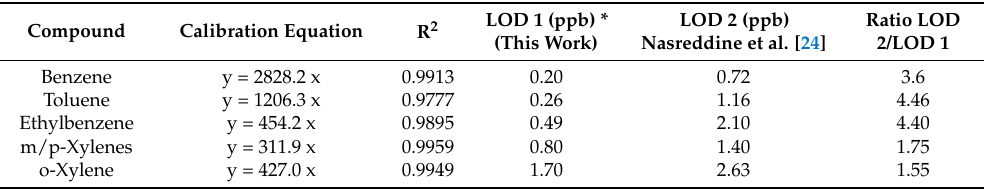
Figure 7. Calibration curves of BTEX performed at 5 mL/min and with a sampling volume of 20 mL. The vertical error bars show the standard deviation for duplicate injections. Table 2. Calibration equations and limits of detection (LOD) obtained for BTEX with and without the preconcentration module (this work, Nasreddine et al., [24]).